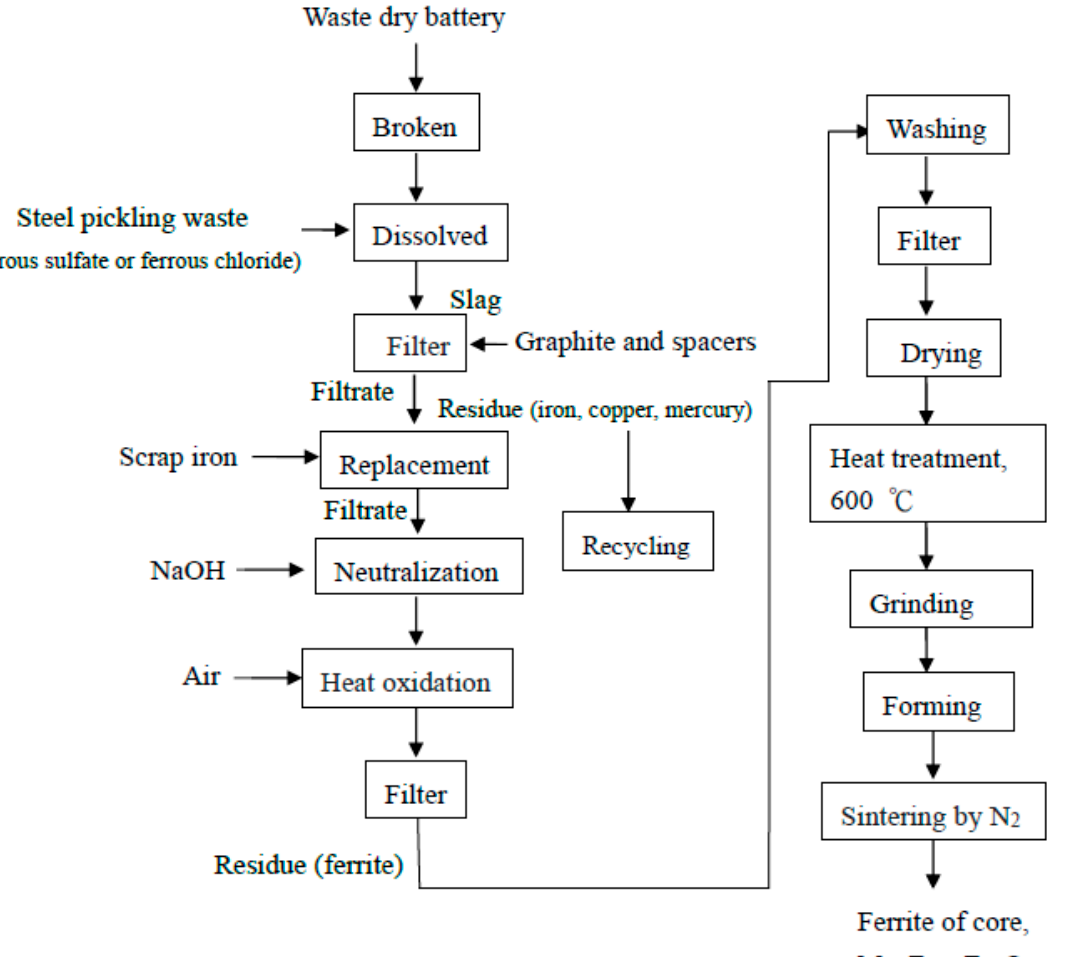
Figure 1. The synthesis of [Mn x Zn 1 − x ]Fe 2 O 4 ferrite from waste battery.